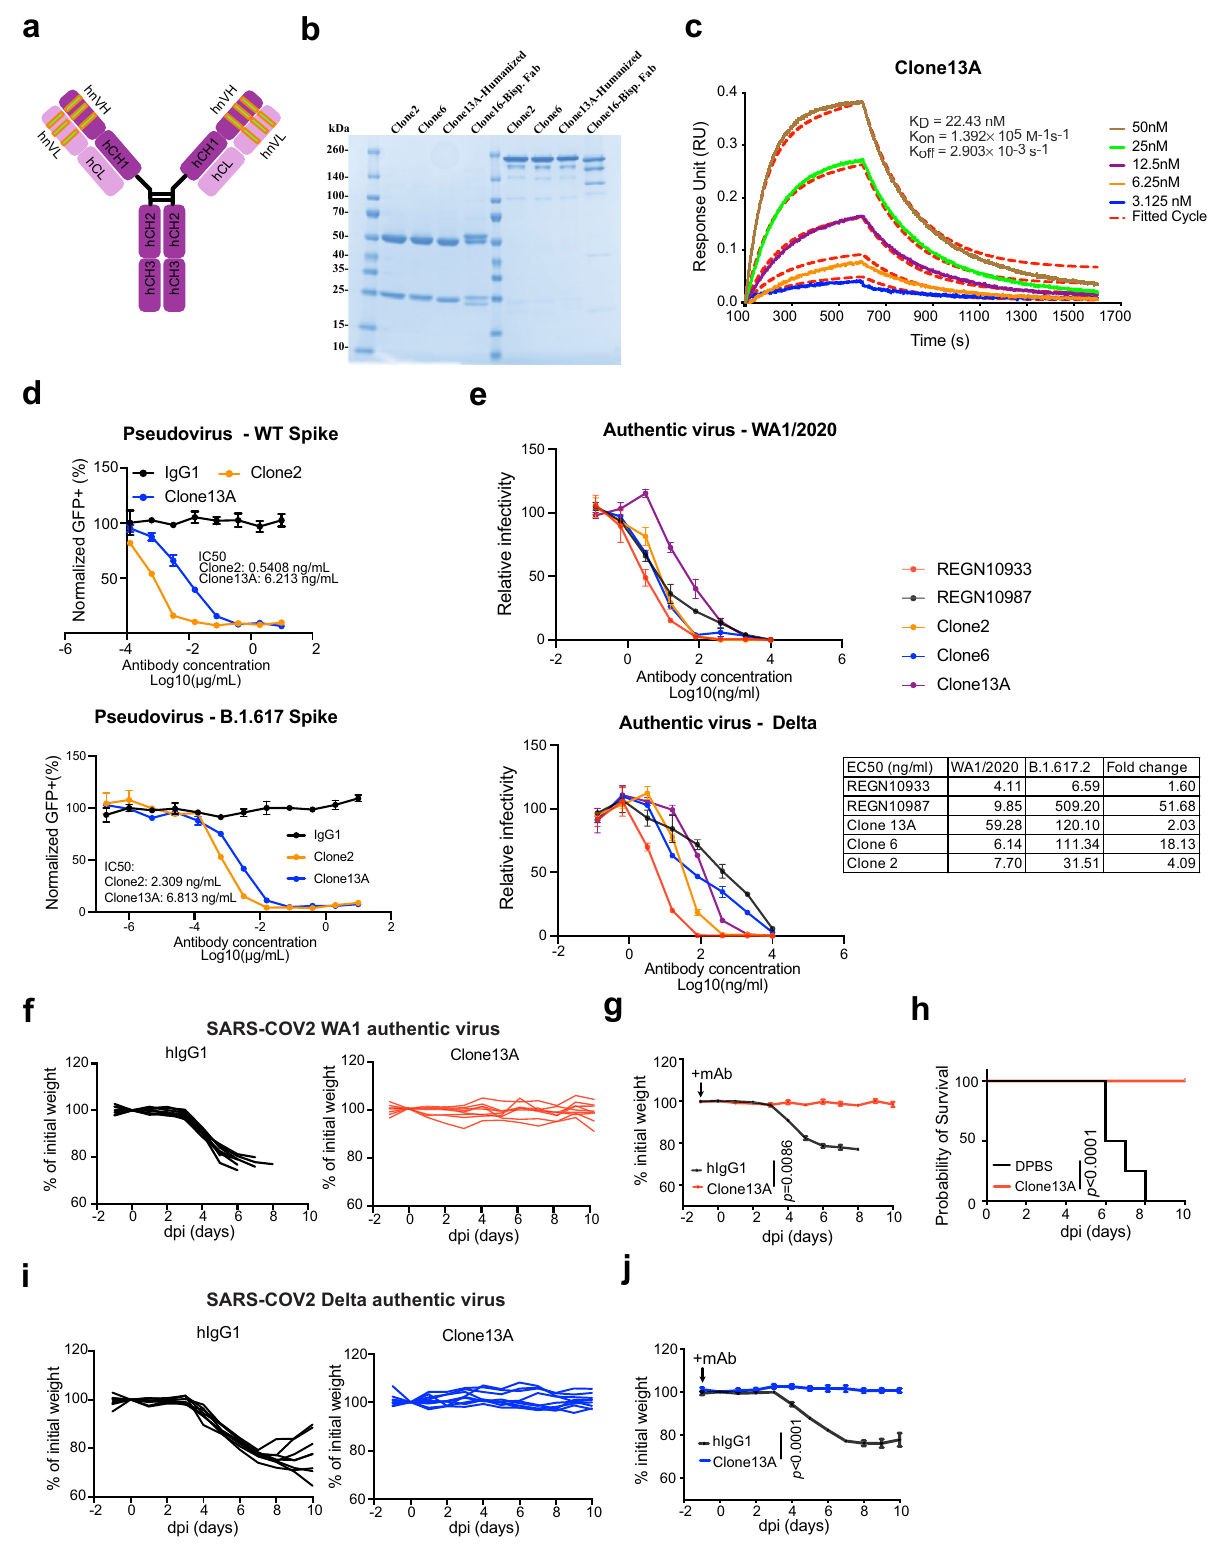
PCR ampli fi ed fragments were gel-puri fi ed and cloned into restriction enzyme digested pFUSE2ss-CLIg-hK by the Gibson assembly (NEB). The pFUSE2ss- HoleHeavy-hG1 possesses three “ hole ” mutations (T366S, L368A, and Y407V) in the CH3 region and a Y349C on the “ hole ” side to form a stabilizing disul fi de bridge. In addition, to get the correct association of the light chain and the cognate heavy chain, the CH1 region in the pFUSE2ss-HoleHeavy-hG1 was exchanged with the constant region of the light chain (CrossMab conformation). The